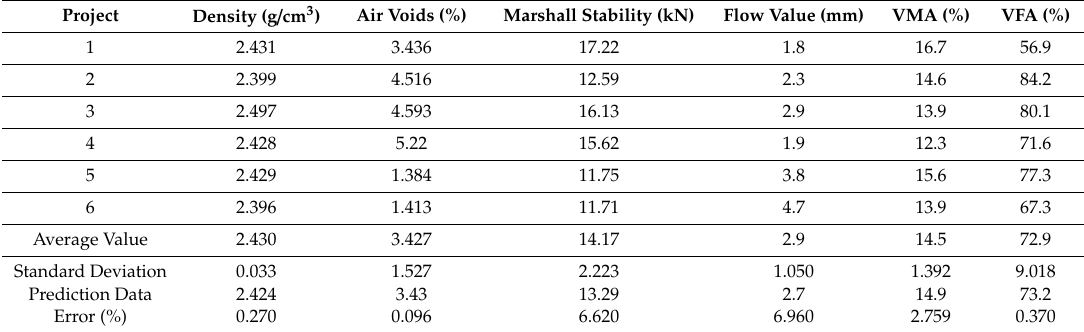
Table 18. Accuracy rate of the response surface